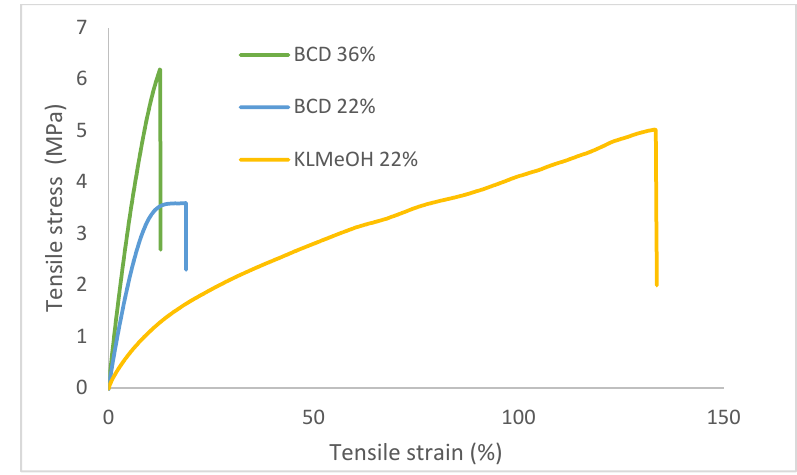
Figure 5. Selected tensile stress-strain curves of different cured epoxy resins.